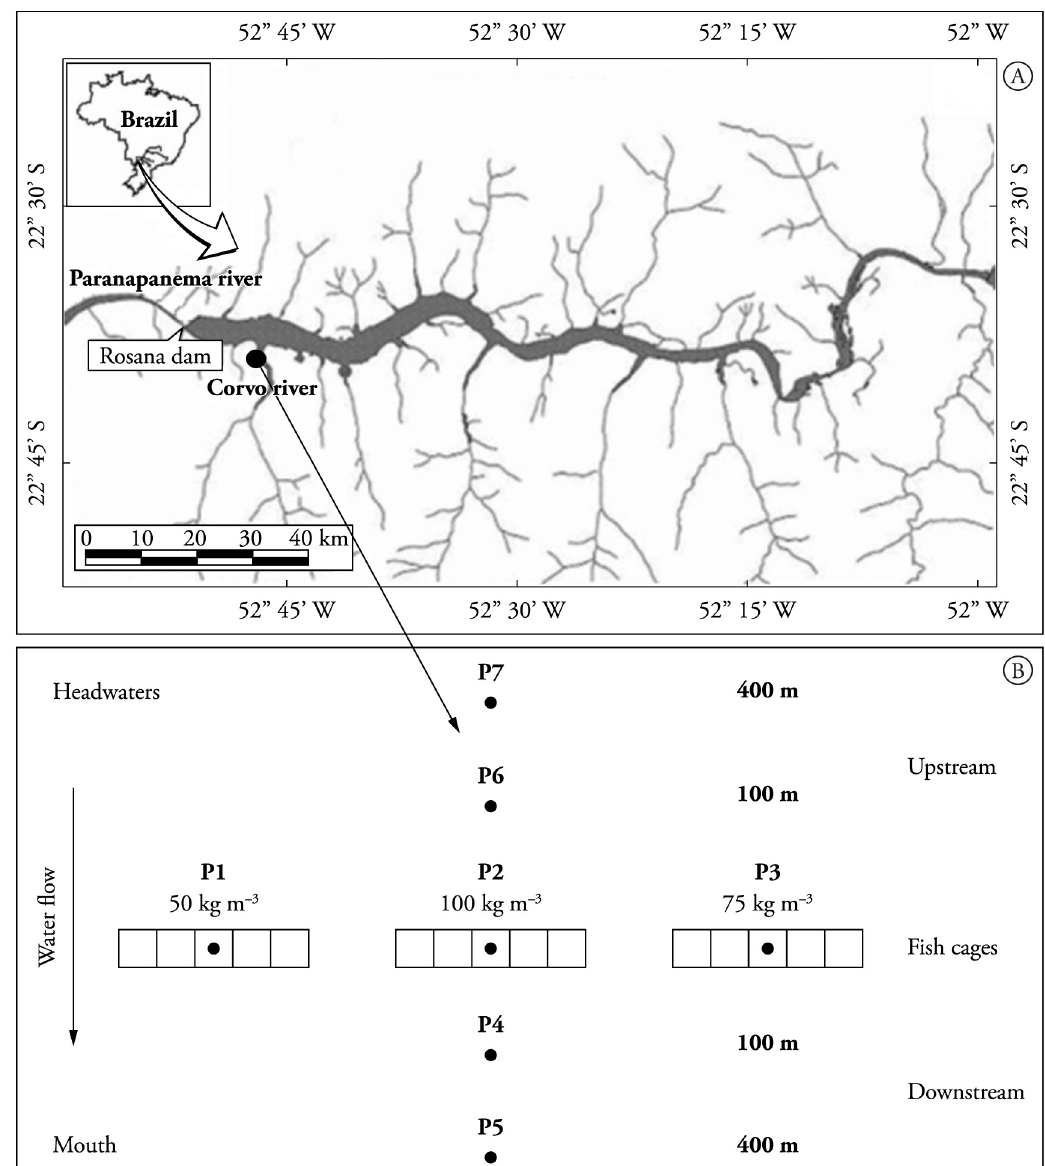
Figure 1. Study area (A) and schematic representation of the sampling points (upstream, fish cages and downstream) (B) in the Corvo